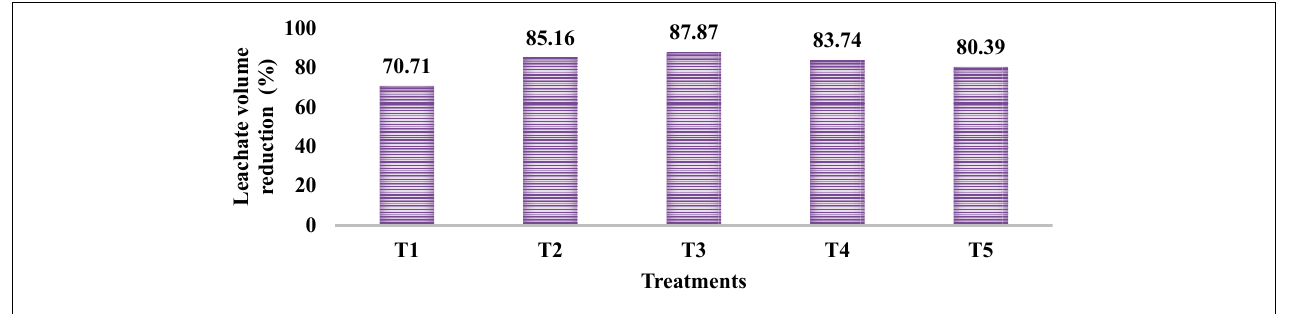
FIGURE 3 | Overall percentage reduction in the leachate at the end of the experiment. TABLE 6 | Changes in physicochemical properties of soil after the application of wastewater. Treatment Initial